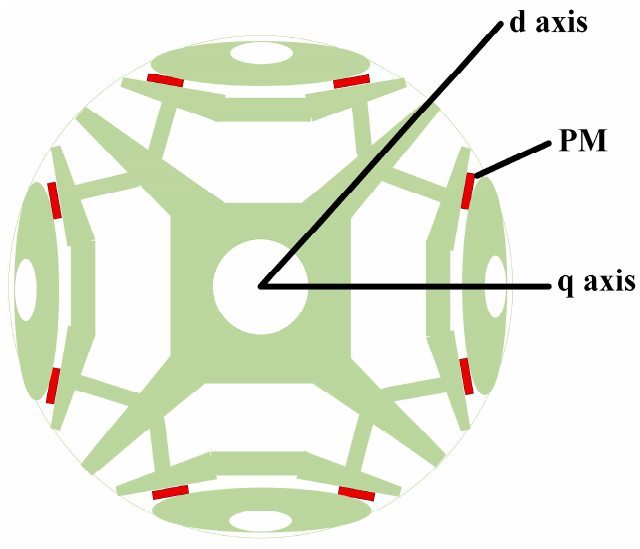
Figure 38. Permanent magnet (PM) assisted SynRM. Permanent magnets are embedded in the rotor [23].